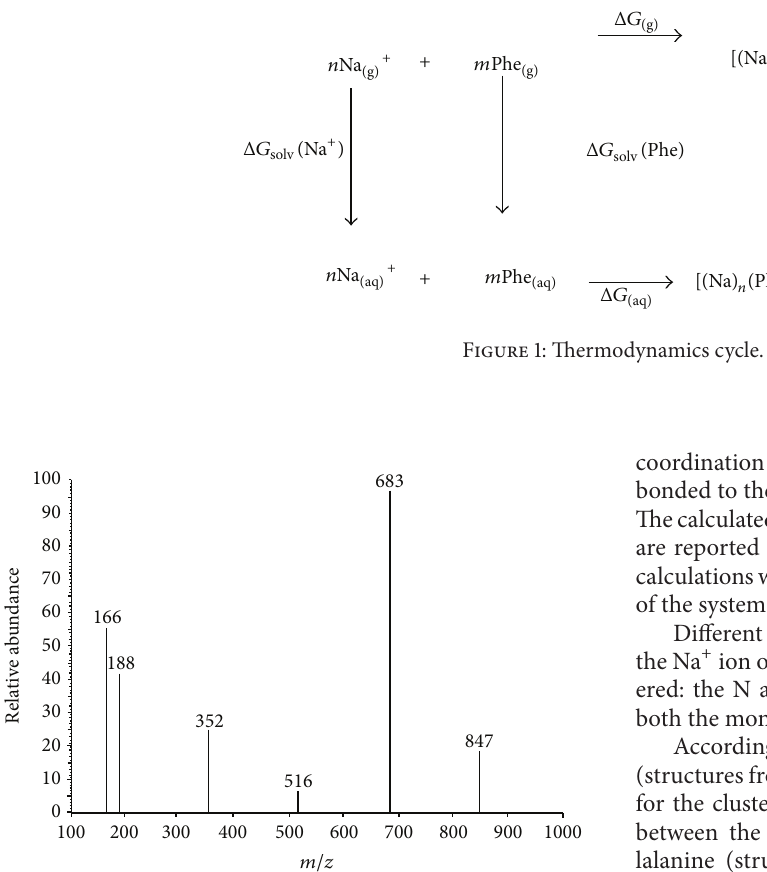
Figure 2: ESI mass spectra in the positive ion mode for monitoring the chemical